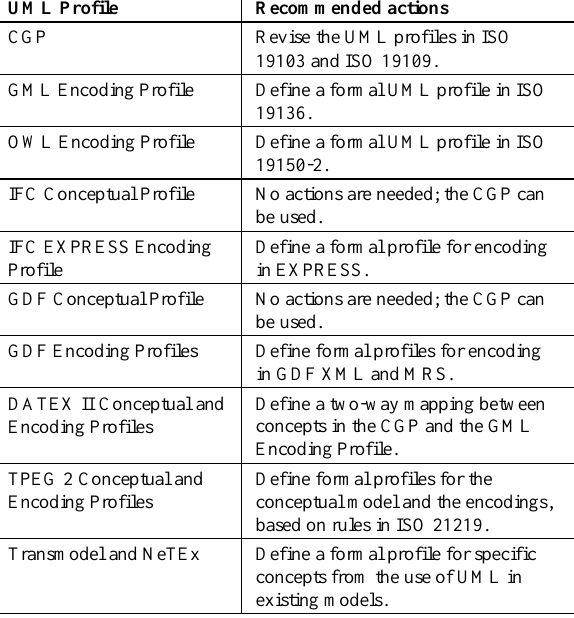
Table 2. Suggested UML Profiles and recommended actions for